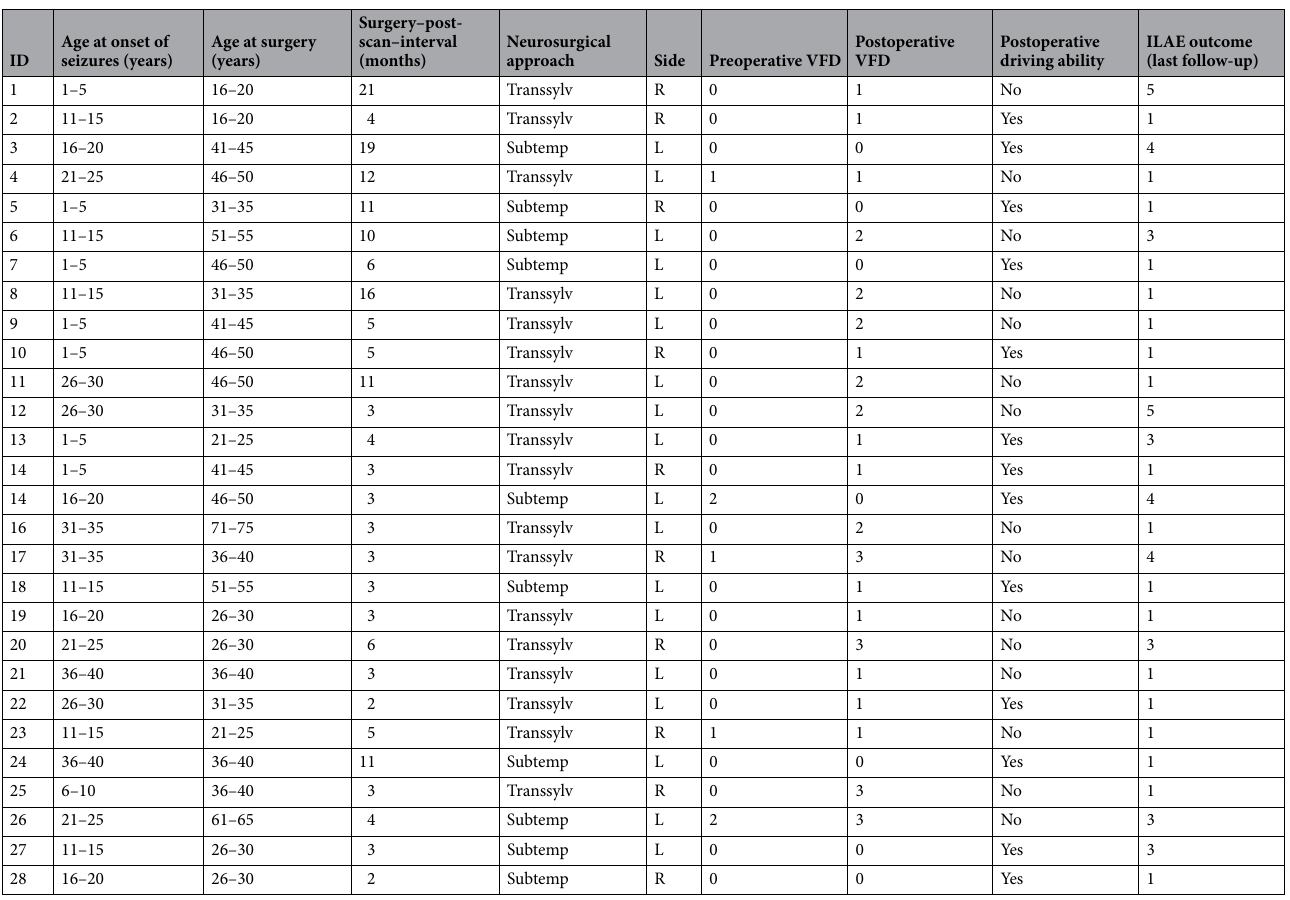
Table 2. Demographical and clinical characteristics of the patient group. Classification of visual field deficit: 0 = no anopia, 1 = incomplete homonymous quadrantopia, 2 = complete homonymous quadrantopia, 3 = incomplete homonymous hemianopia. (L = left, R = Right, subtemp = subtemporal access, transsylv = transsylvian